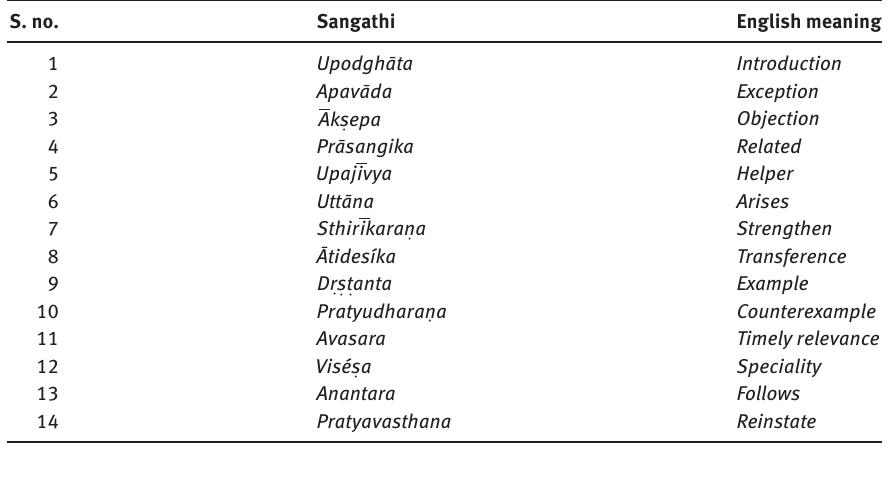
Table 1. Sangathis and Their English Meaning.